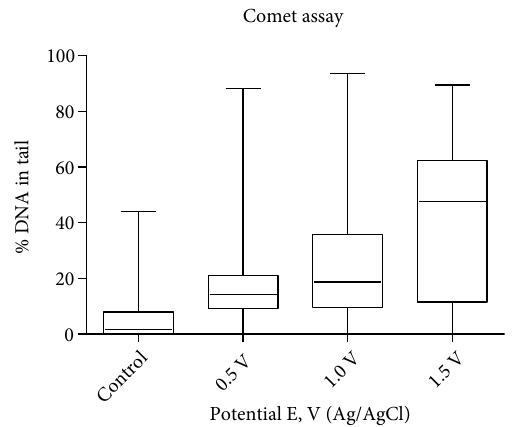
Figure 5: Box and whiskers plot of representative data shown in Figure 4. Boxes represent data within 25 th and 75 th percentiles. The horizontal line within each box represents the median value. Extended bars represent the max and minimum